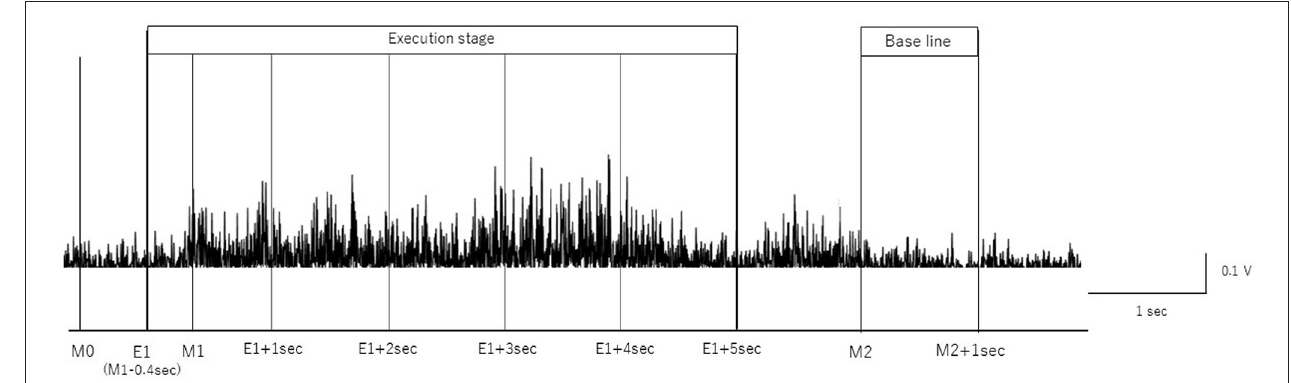
FIGURE 1 | Definition of onset and offset of swallow. The onset and offset of volitional swallowing are defined according to swallow-related submental group muscle activities form Case 1. M0 is the E1 is the time to initiate swallowing, M1 is the time to start the main muscle activation, and M2 is the time to return to baseline. The surface EMG of the submental group muscle trace during a single swallow is